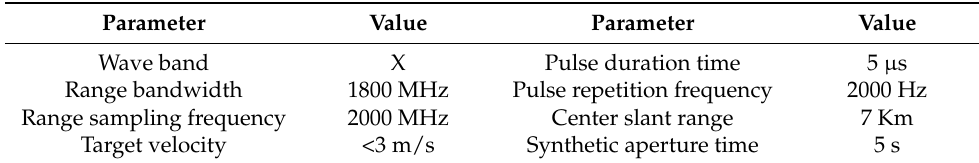
Table 5. The parameters of X-band airborne SAR system.